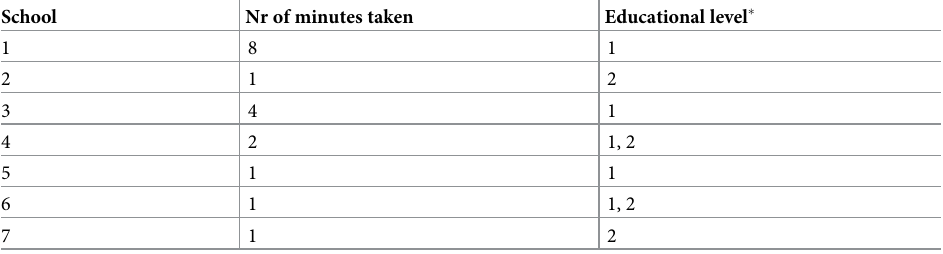
Table 1. Overview of spread of schools and educational level used for minutes.